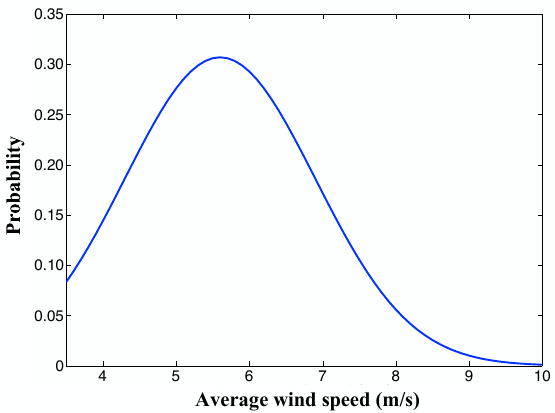
Figure 3. Capturing the long-term variability AWS over the contiguous United State of America; µ = 5.6 m/s and σ = 1.3